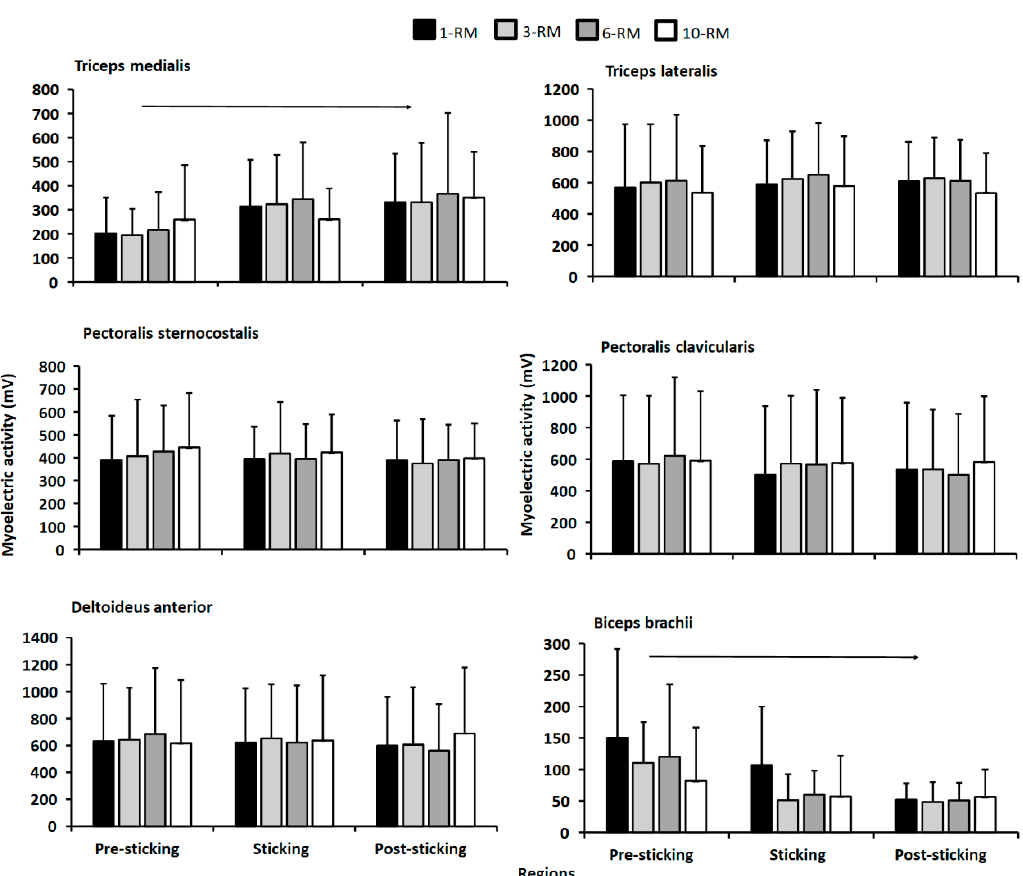
Figure 4. Mean ± SD electromyographic activity for the medial triceps, lateral triceps, sternocostal pectoralis major, clavicular pectoralis major, anterior deltoid and biceps brachii in the pre-sticking, sticking and post-sticking region for the 1-RM, 3-RM, 6-RM, and 10-RM bench press exercise. → Indicates a significant difference in electromyographic activity between the pre-sticking and the post-sticking region in the bench press exercise ( p < 0.05).